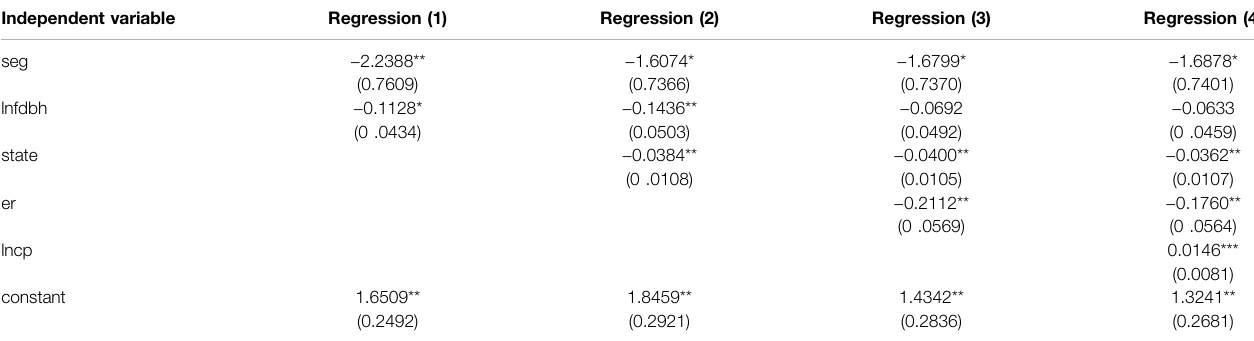
TABLE 7 | The impacts of market segmentation on thermal power generation ef fi ciency.